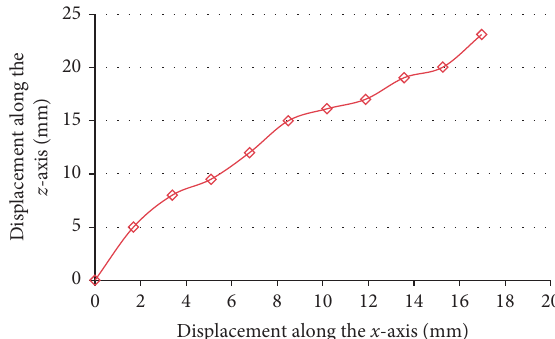
Figure 11: Relation between the displacement of x - and z - axes of the TLET